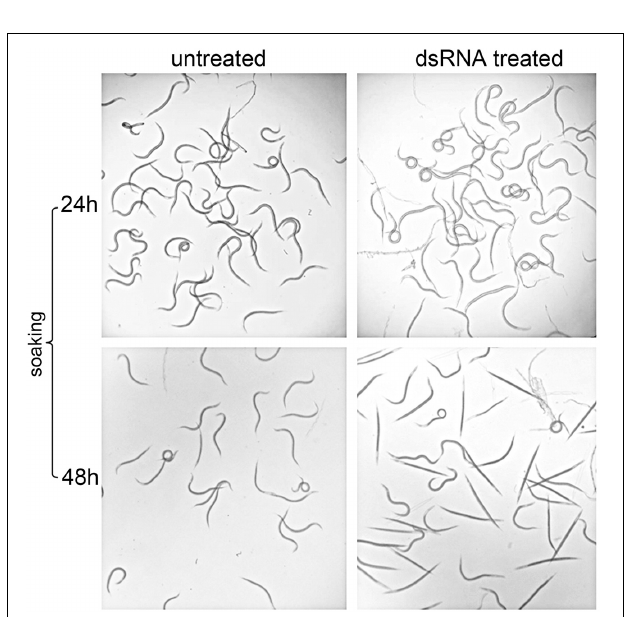
FIGURE 8 | Light microscopy observations of RNAi mediated phenotypes of Infective Juveniles (IJs) of Heterorhabditis bacteriophora treated with dsRNA Hb - hsp 90-1 after 24 and 48 h soaking at 23 ◦